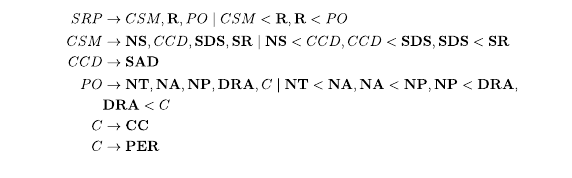
FIGURE 1 | PHATT PL for the ROSA